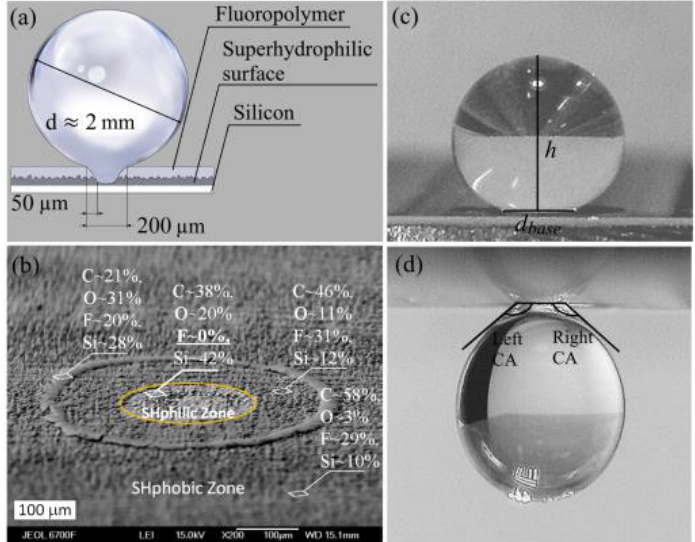
Figure 1. ( a ) Schematic of the substrate. ( b ) SEM image of the seat after the evaporation of colloidal solution droplets of SiO 2 particles in distilled water. The indicated compositions in the corresponding square regions were determined by the EDX method. ( c ) Optical image of a sessile droplet in the seat. ( d ) Optical image of a droplet in the seat. h , d base , Left CA, and Right CA are the droplet height, base diameter, and left and right contact angles, respectively.